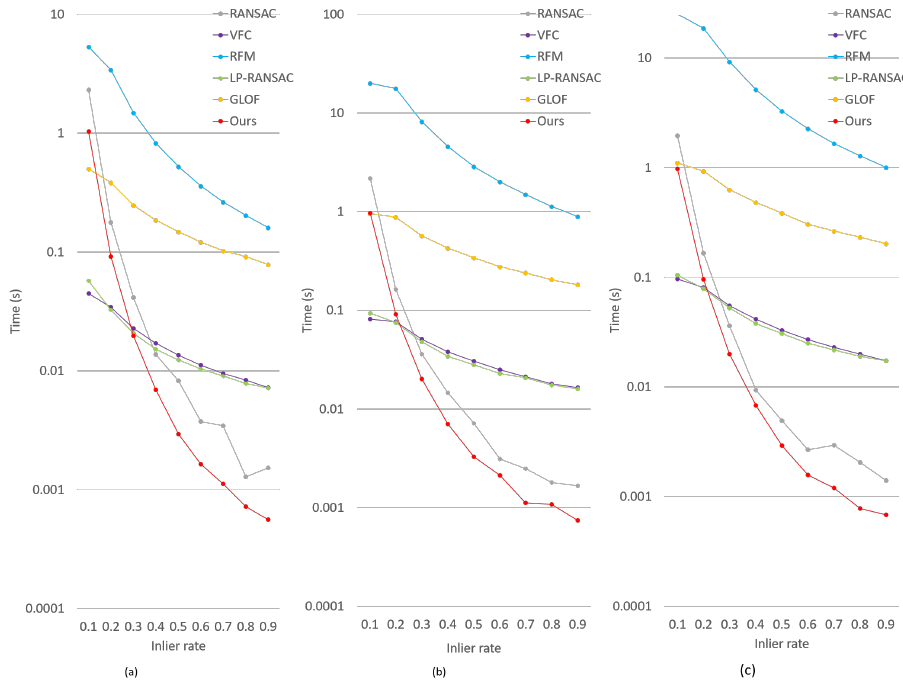
Figure 9. Execution time performance comparison of the considered six methods. ( a ) For “Airport”. ( b ) For “Small Village”. ( c ) For “University Campus”.